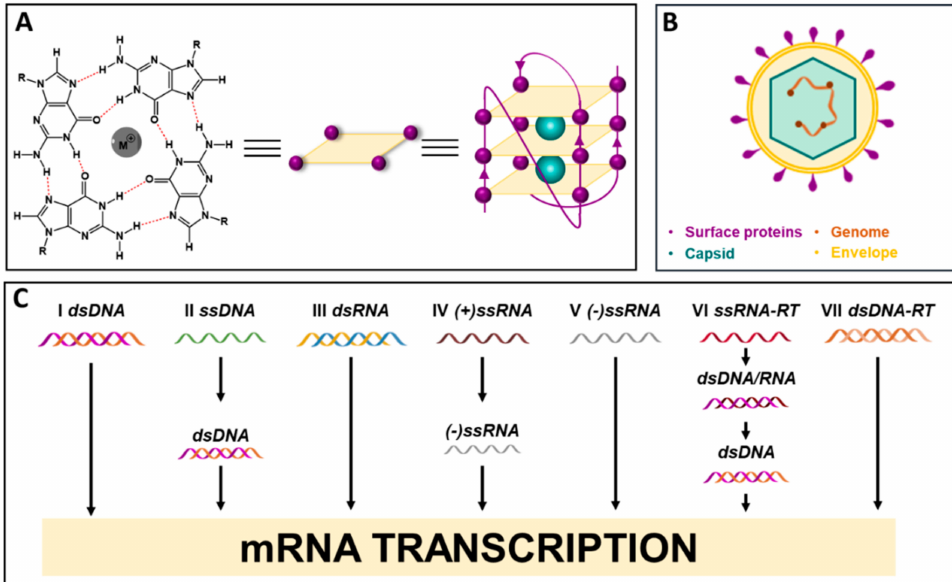
Figure 1. ( A ) Chemical structure of G-tetrad and G-quadruplex assembly; ( B ) virus structure and main components; ( C ) Baltimore classification of